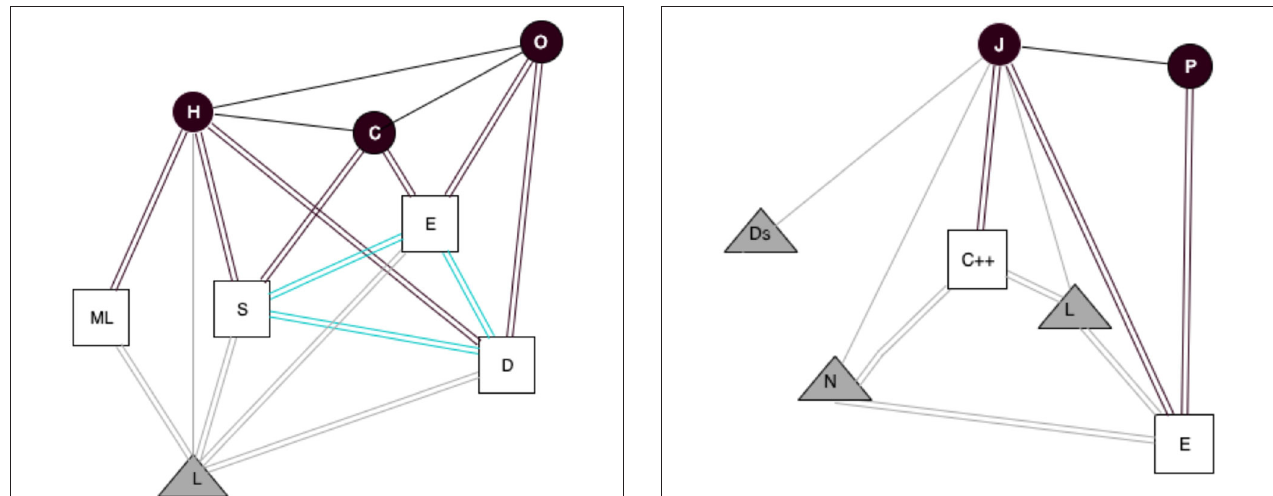
FIGURE 4 | Socio-material network based on Harry’s observation. Circle, actors (H, Harry; C, Carl; O, Owen); Triangle, analog objects (L, Laptop); Squares, digital objects (S, Skype; E, Email; D, Document; ML, MatLab); Black lines, social ties; Gray lines, usage of analog objects; Black double lines, usage of digital objects; Cyan double lines, digital links; Gray double lines, analog/digital links.